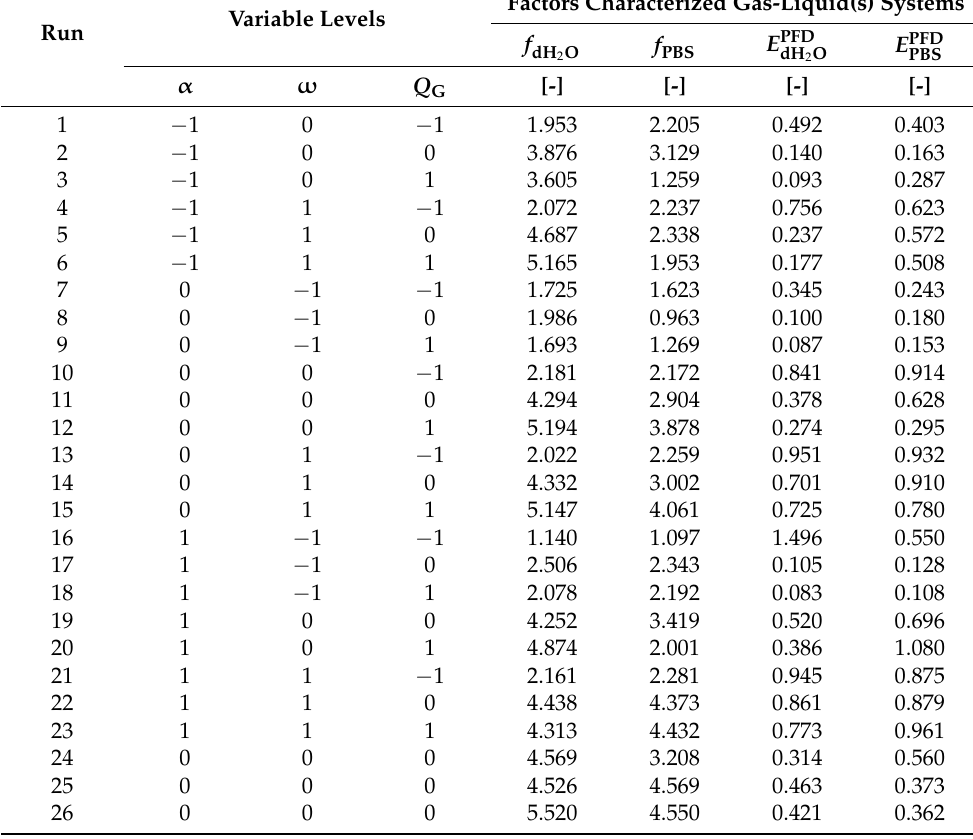
Table 3. The values of the interface development factors— f dH , E PFD — calculated for all runs of the evaluated BBD. — E PFD PBS dH 2 O Variable Run